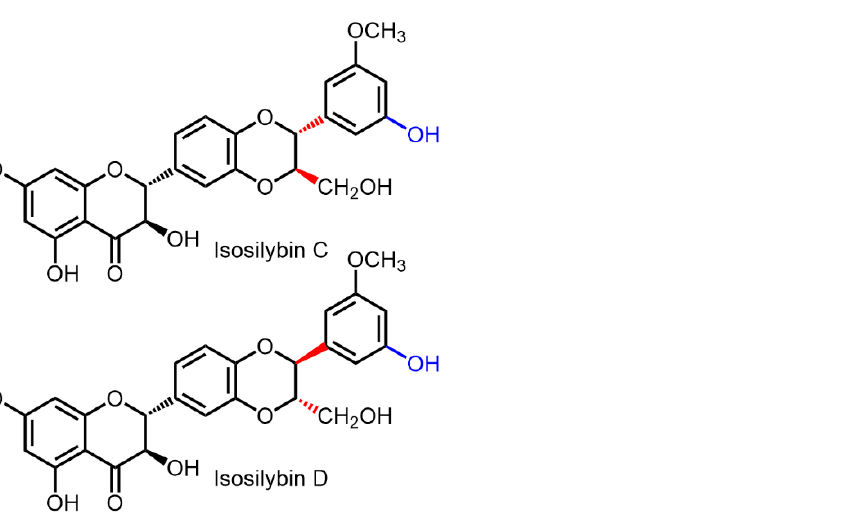
Figure 11. Structures of minor silymarin components isosilybin C and isosilybin D [53]. Anti-tumor efficacy has been demonstrated in vivo for silybin A, silybin B, isosilybin A, and isosilybin B on the DU145 human prostate xenograft in athymic nude mice; they can inhibit tumor growth after oral treatment with doses of 50 and 100 mg/kg body weight [127]—isosilybin B was most effective. The flavonolignans tested inhibit tumor angiogenesis biomarkers (nestin and CD31) and signaling angiogenesis molecules (VEGF, VEGFR1, VEGFR2, phospho-Akt, and HIF-1a) without affecting angiogenesis in normal healthy tis-